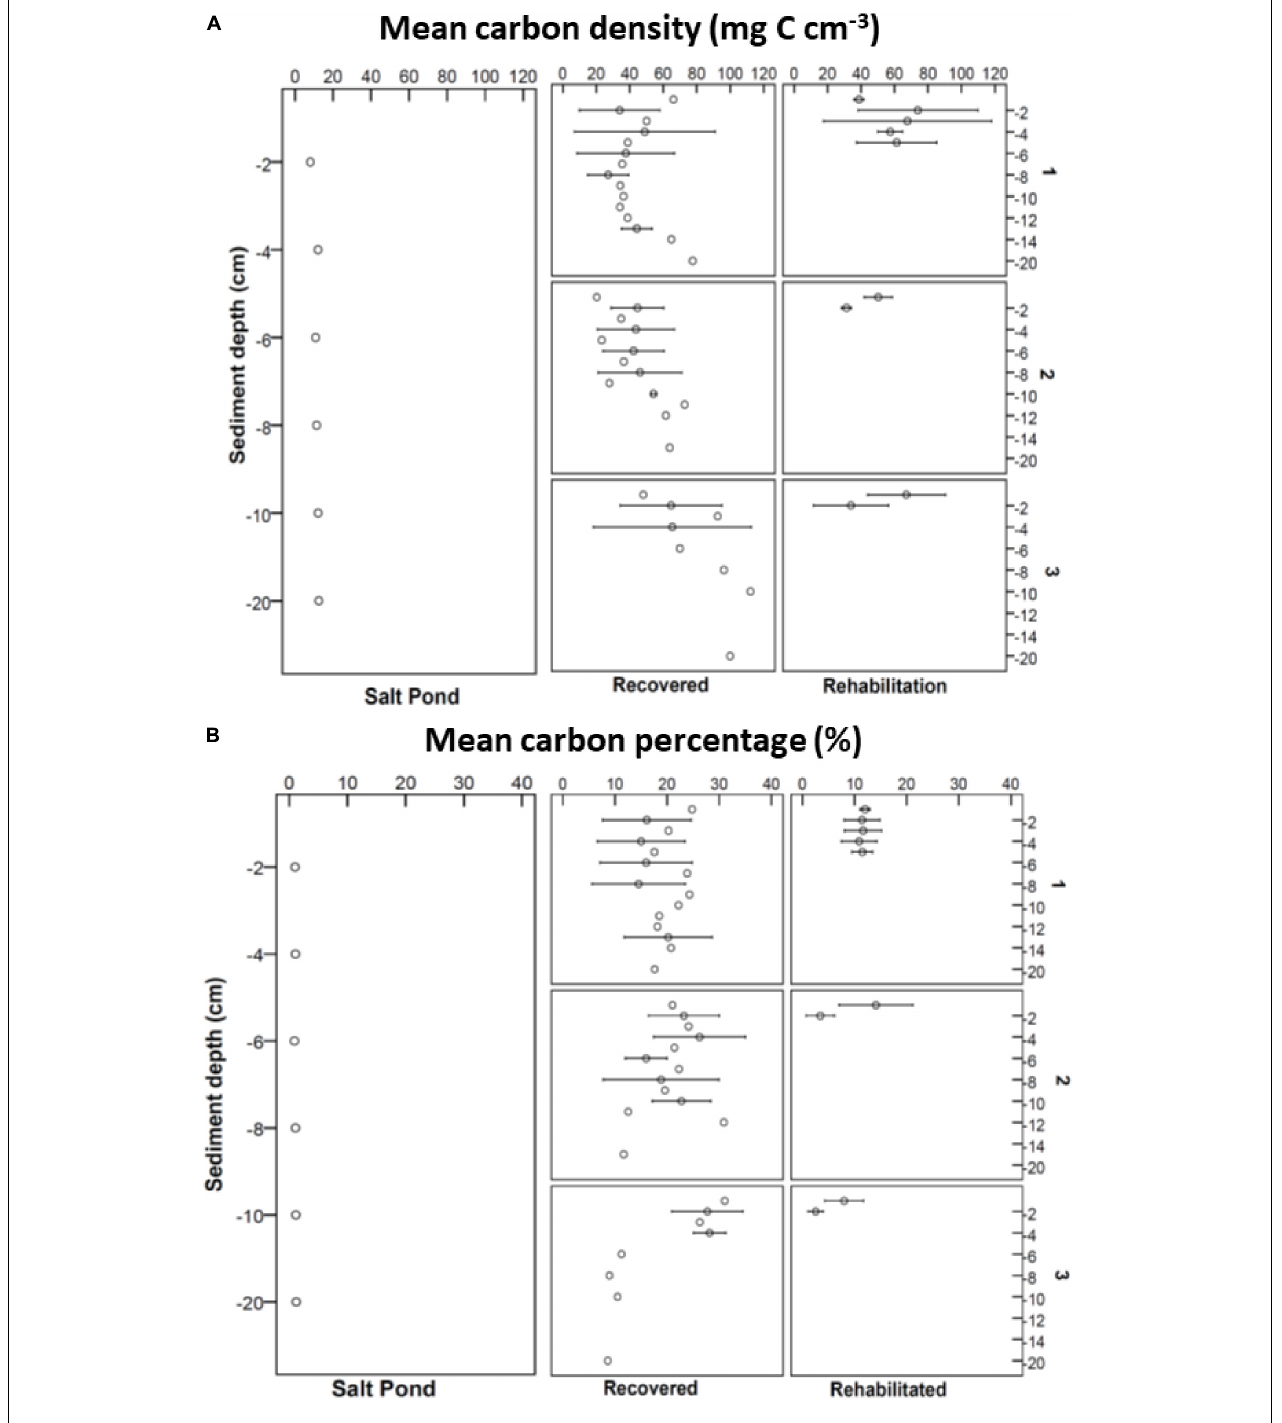
FIGURE 4 | Mean carbon density (mg C cm - 3 ) over depth sampled (cm) (A) and mean carbon percentage (%) over depth samples (cm) (B) at the salt pond, recovered, and rehabilitated sites.